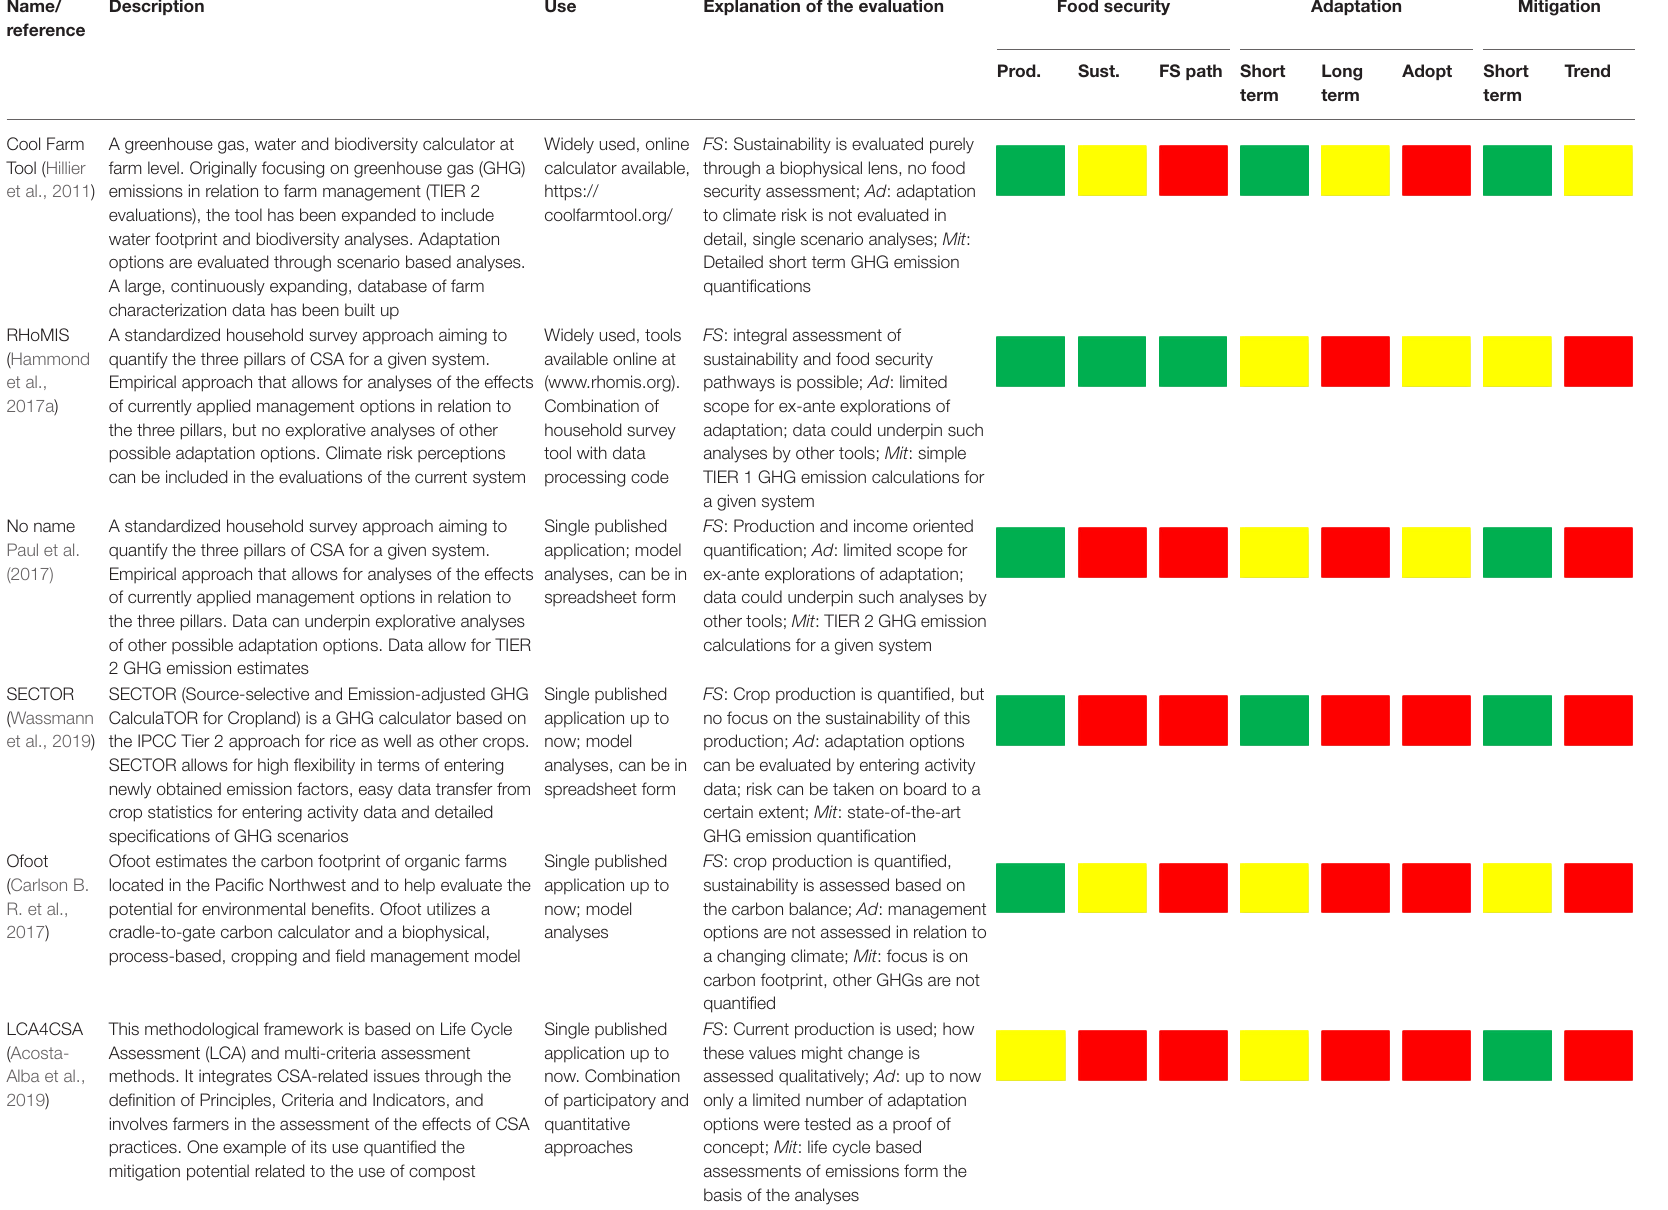
TABLE 1 | Overview of existing climate smart agricultural (CSA) assessment frameworks. Name/ reference